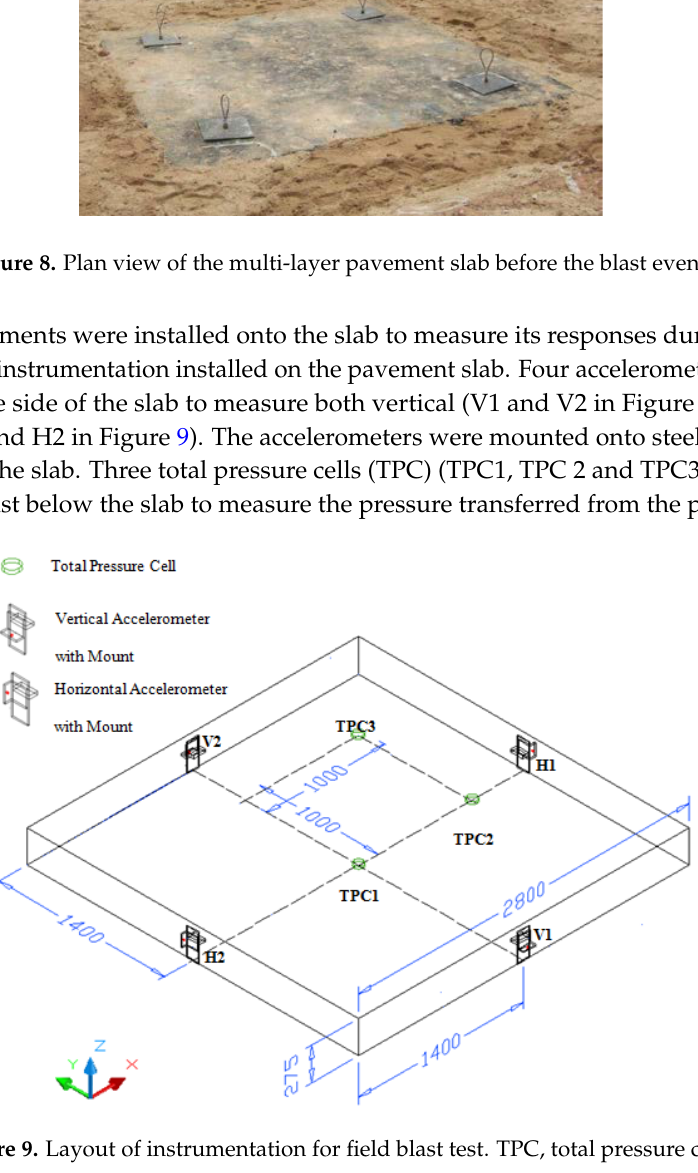
Figure 10. Finite element model of the multi-layer pavement slab. In the numerical model, AC, ECC and HSC are all grouped as concrete-like materials and modelled by the KCC model [20,23]. The basic parameters for these three materials are listed in Table 3. The parameters for AC material in the KCC model can be found in Section 3. While the process of the determination of HSC and ECC parameters for KCC model is the same as that mentioned in Section 3, the detailed parameters can be referred to Wu [20]. The Drucker–Prager model and plastic-kinematic model [17] are employed to model the foundation soil and geogrid,